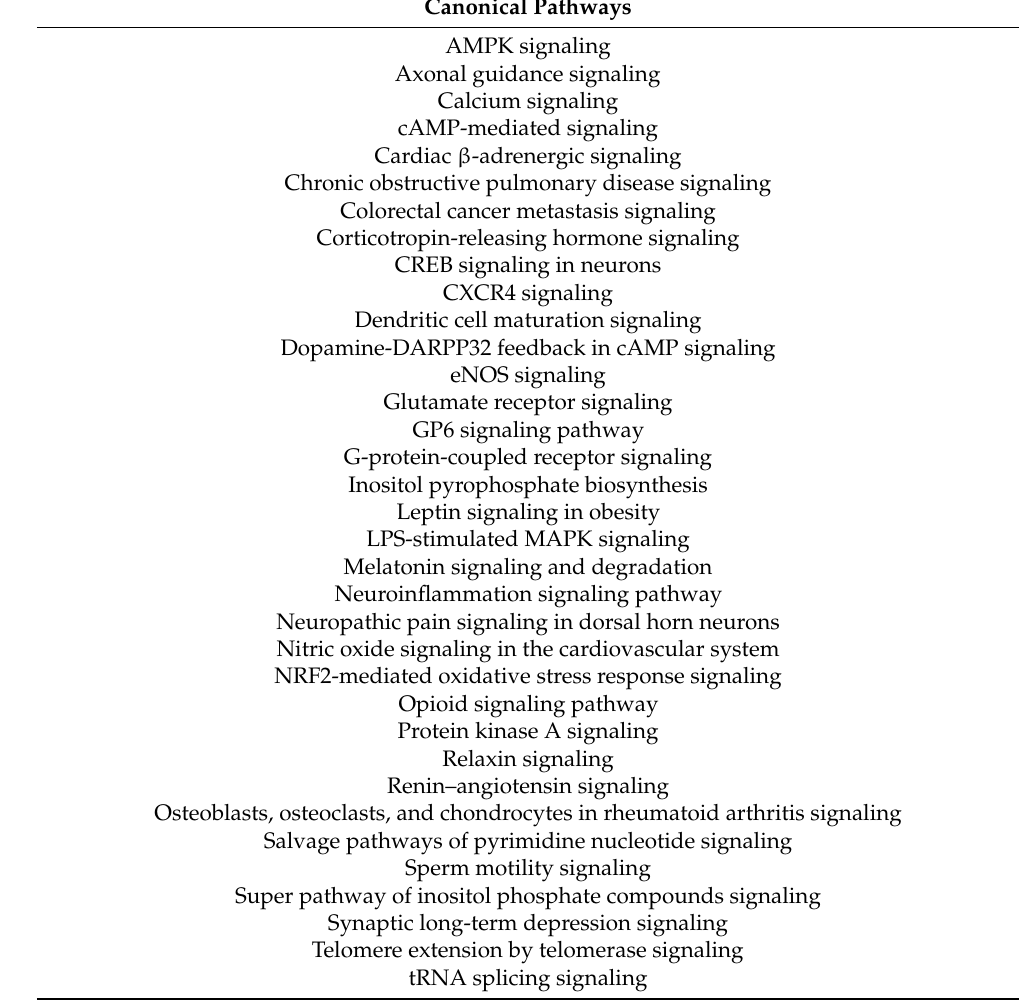
Table 3. The effects of adaptogens on canonical pathways are commonly involved in regulating adaptive stress response signaling; adapted from Reference [6].